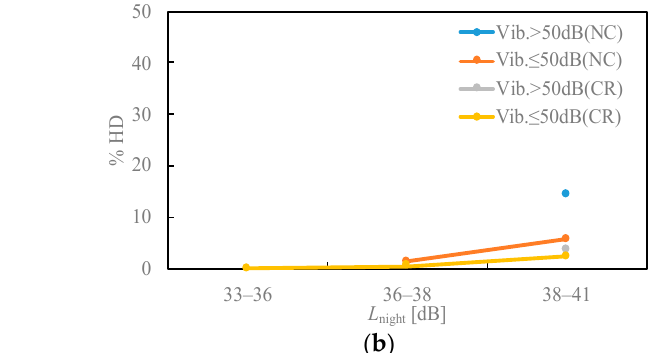
Figure 4. Relationships between noise exposure level and self-reported sleep disturbances. ( a ) Falling asleep; ( b ) awaken- ing.